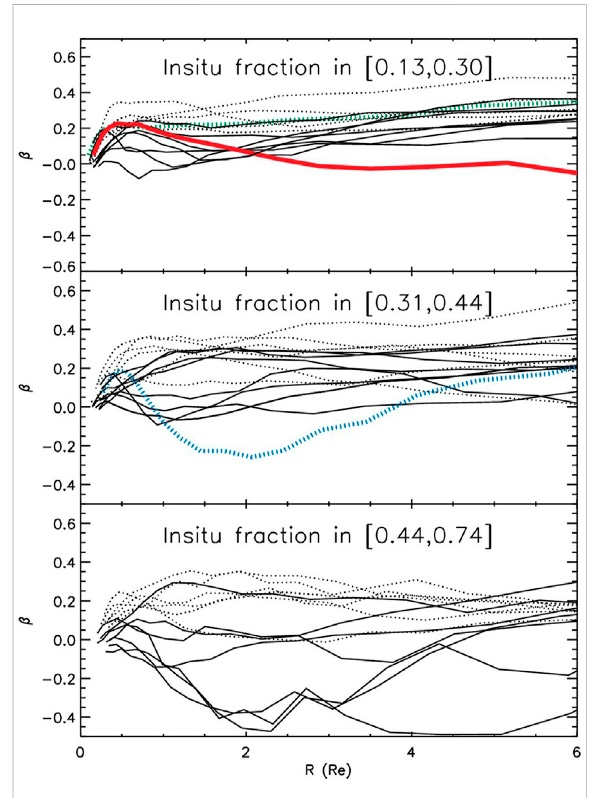
FIGURE 5 Velocity anisotropy pro fi les for the simulated galaxies from Wu et al. (2014) in bins of in situ fraction of stars within 10 per cent r vir . Solid lines are for fast rotators while dotted lines are for slow rotators. Colored curves depict the three fi ducial galaxies: green dotted line for a slow rotator, blue dotted line for a slow rotator with peaked λ (r) pro fi le at 2R e , and red solid line for a fast rotator. Galaxies with low in situ fractions have more radially anisotropic orbit distributions, while tangential anisotropy is seen only for systems with high in situ fraction. Image reproduced from Figure 11 of Wu et al. (2014) with